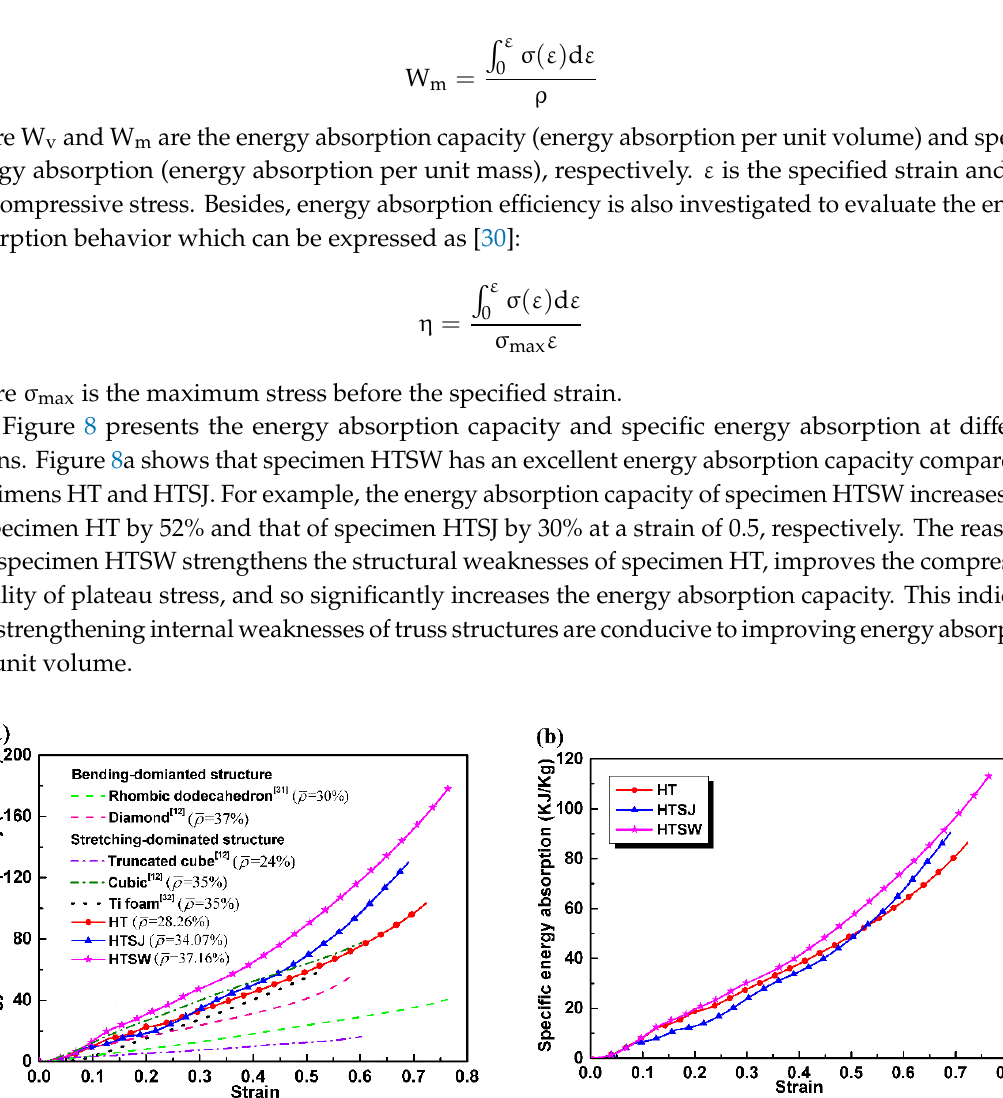
Figure 8. Energy absorbed at different strains: ( a ) energy absorption per unit volume and ( b ) energy absorption per unit mass.